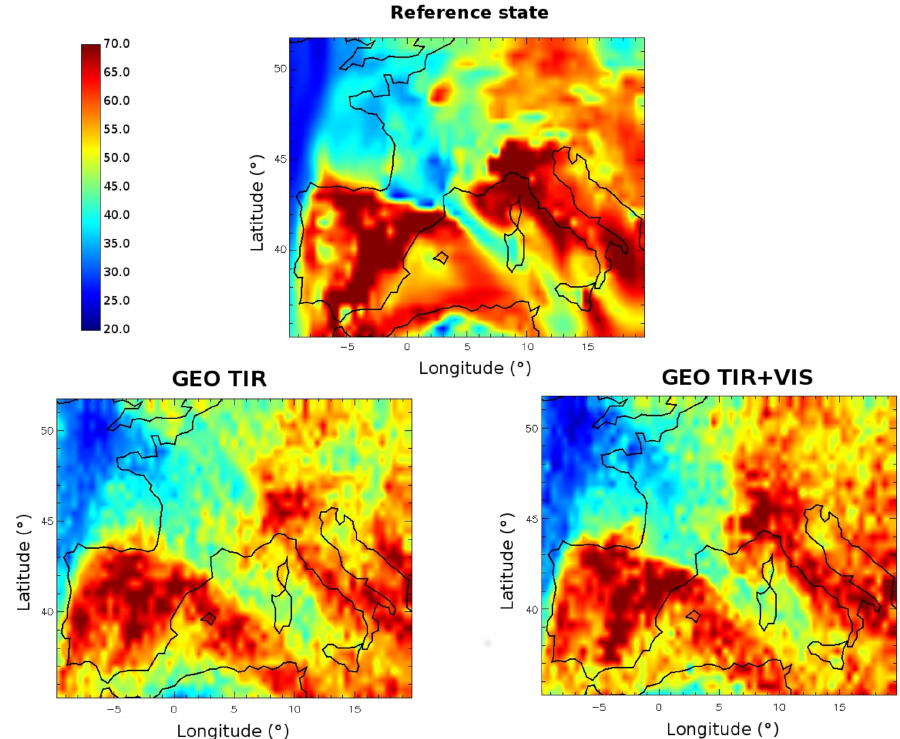
Figure 7. 0–1km ozone column (ppbv) for the 11 July 2009 at 16:00UTC for the reference state (top), GEO TIR (bottom left panel) and GEO TIR + VIS (bottom right panel). The colour bar indicates the ozone concentration in parts per billion by volume (ppbv), with red/blue indicating relatively high/low